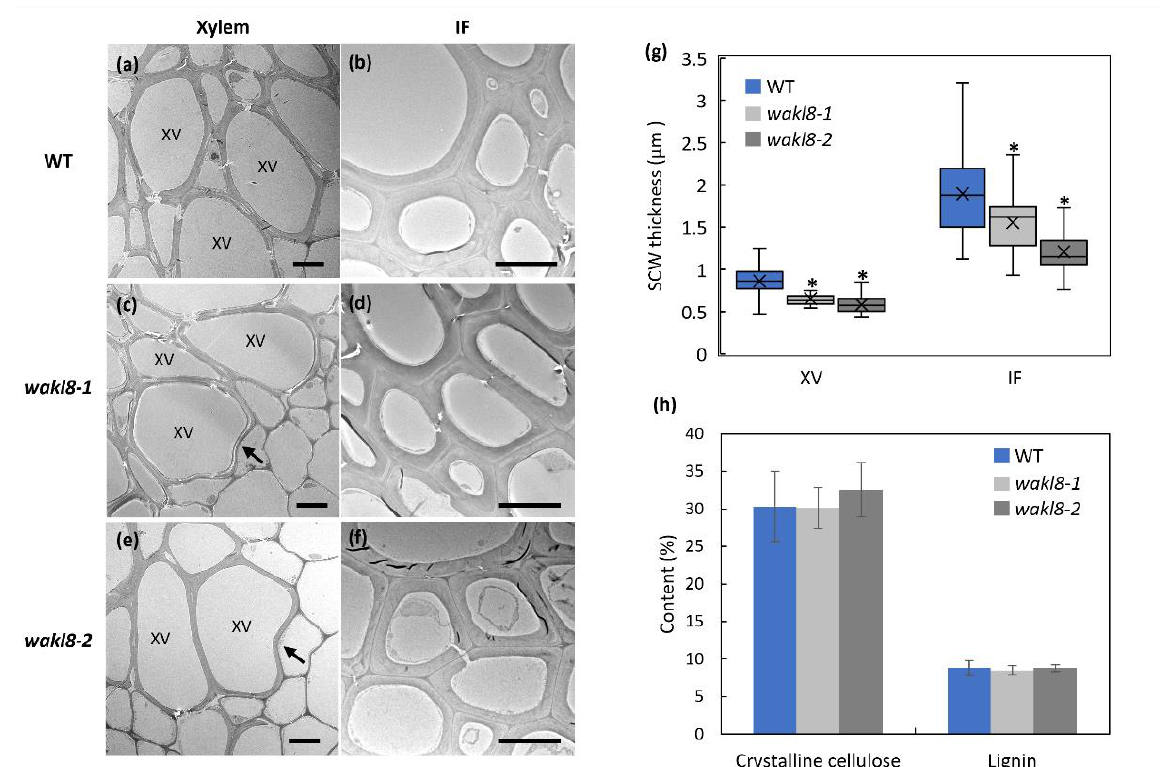
Figure 5. Transverse stem sections imaged by transmission electron microscopy (TEM) and measurement of stem crystalline cellulose and lignin contents. TEM imaging of xylem vessel (XV) and interfascicular fiber (IF) walls from WT ( a , b ), wakl8-1 ( c , d ), and wakl8-2 ( e , f ) plants at growth stage 6.5 [45]. Arrows indicate sites of collapsed XVs. Scale bar = 5 µ m in ( a – f ). ( g ) Quantification of XV and IF wall thickness. ( h ) Measurement of crystalline cellulose and lignin contents in stems. Data shown as average ± SD acquired from three biological replicates. * Significant difference compared with WT plants, p < 0.05 using Student’s t